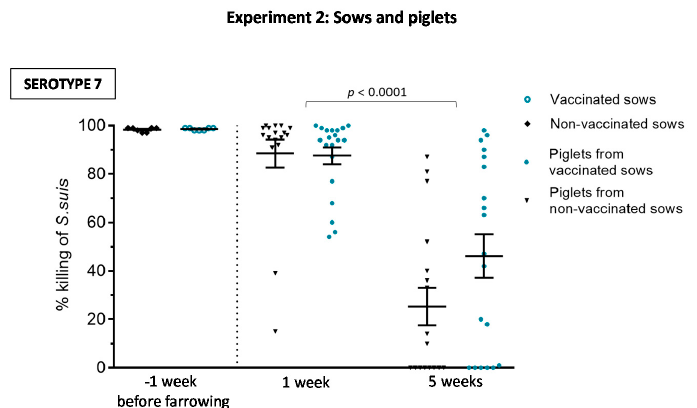
Figure 9. Experiment 2: Opsonophagocytosis killing of S. suis serotype 7 induced by serum antibodies from sows and from their piglets. Blood samples were collected one week before farrowing from seven vaccinated and seven non-vaccinated sows and from randomly chosen piglets (1 per sow) at one and five weeks of age ( n = 20 per group) to evaluate their functionality in an opsonophagocytosis assay (OPA). For OPA, blood leukocytes were mixed with S. suis serotype 7 (vaccine strain) at a multiplicity of infection of 0.01. Control sera or sample sera from vaccinated or non-vaccinated animals were added to a final concentration of 40% v/v in microtubes, which were incubated for 4 h. After incubation, viable bacterial counts were performed and the percentage of bacterial killing determined. The results are expressed as percent of bacterial killing for individual sera, with horizontal bars representing mean ± SEM. Values significantly different are shown in the graph with corresponding p value.